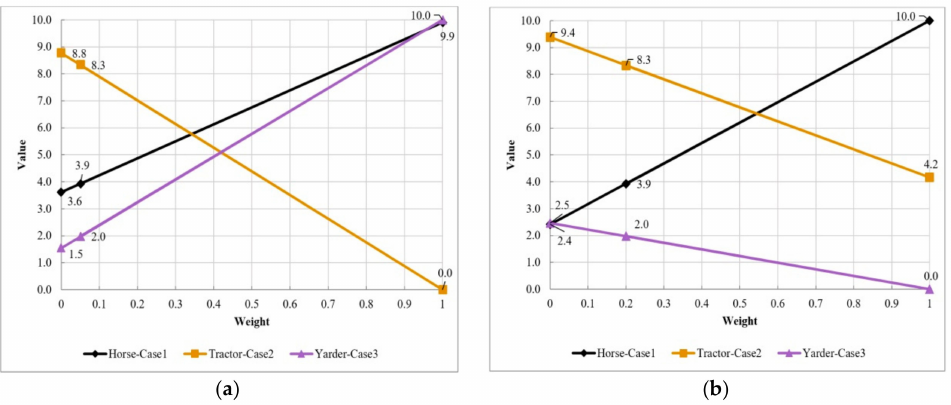
Figure 6. Results of sensitivity analysis using MAUT method when changing weight of #8 employment